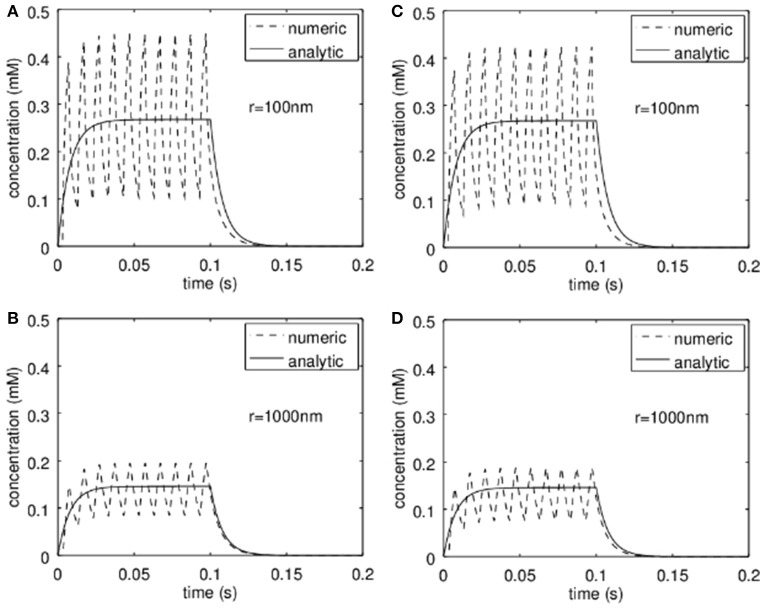
Comparison of the analytic approximation with a finite-volume simulation. (A,B) show the time course assuming no active take up of zinc by the pre- and post-synapse respectively at a distance r = 100 nm (A) and r = 1 μm (B). This corresponds to the assumption used for the derivation of the analytical model. In (C,D) the analytical solution (identical to that in A,B) is compared to a simulation where active take up of zinc is simulated. Clearly at physiological transport rates the concentrations are slightly lower but do not deviate much from the analytical approximation.